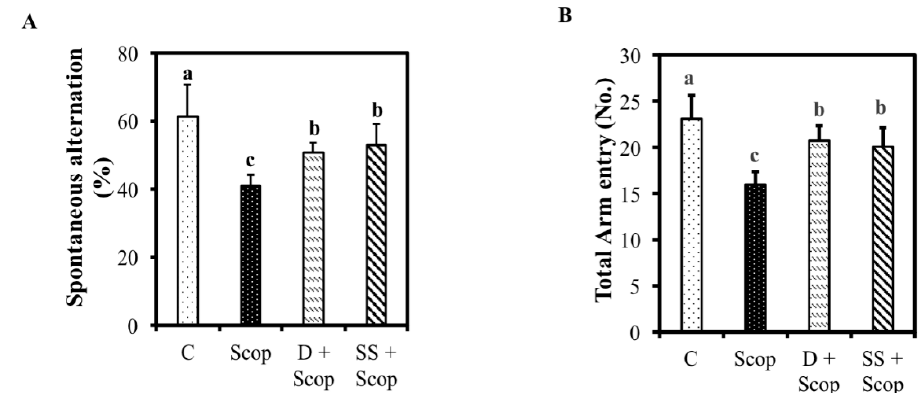
Figure 4. Effect of Stachys sieboldii in scopolamine induced memory impairment was assessed by Y-maze. SS reduced spontaneous alternation (%) ( A ), and Total arm entry (No.) ( B ). All values are mean ±SD ( n = 10). Mean with different superscripts in the same row indicates significant difference by ANOVA with Tukey’s test at p < 0.05 compared to control group.